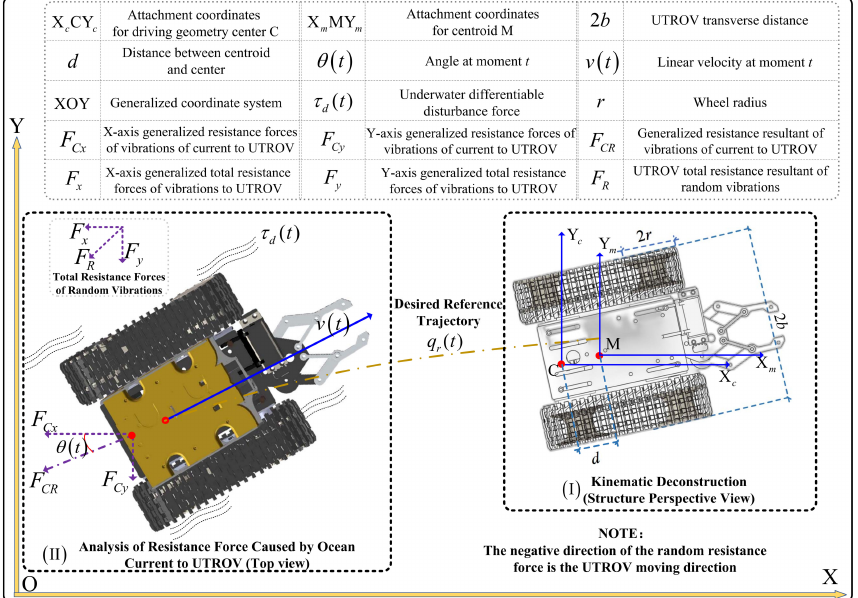
Figure 1. Schematic diagram of UTROV geometric kinematics and underwater environmental resistance force analysis.